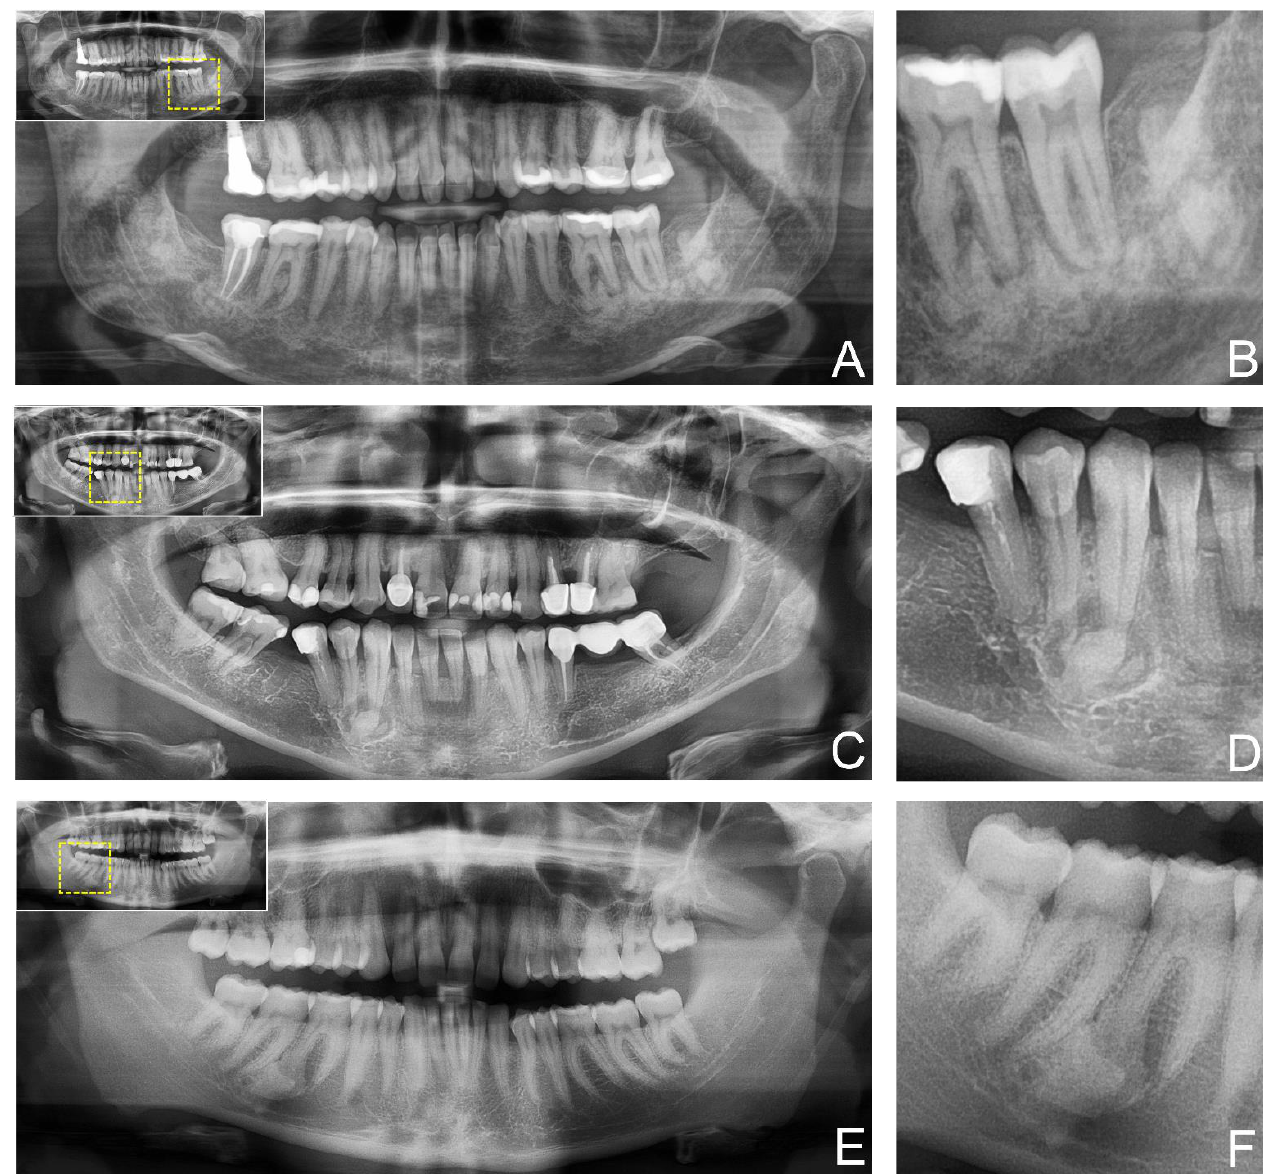
Figure 2. Study participants’ two-dimensional panoramic radiography (PAN) providing anatomical information of the fibro-osseous lesion. ( A ) shows an ossifying fibroma in the posterior mandible. In contrast ( C ) shows cemento-osseous dysplasia at the canine in the fourth quadrant, while ( E ) shows a cemento-osseous dysplasia at the first molar in the fourth quadrant. For orientation, the dotted rectangles in the corner show the enlarged area of the region of interest ( B,D,F ). Bone biopsies for histopathological diagnosis were taken in 100% of patients with ossifying fibroma and fibrous dysplasia; slightly less patients with cemento-osseous dys- plasia underwent a biopsy (90%). Surgical resection of the lesion was mostly performed in patients with ossifying fibroma (41%), followed by fibrous dysplasia (29%) and ce- mento-osseous dysplasia (15%). The main complaints before the surgical intervention were pain, swelling, or sensory disturbance; otherwise, the occurrence of a relapse was an indication. A recurrence of cemento-osseous dysplasia in 5% and ossifying fibroma in 6% was observed after initial resection. The postoperative follow-up interval for cemento-os- seous dysplasia was set at 6 months in 45% of cases, while for the rest, the follow-up in- terval was largely determined according to the patient’s needs. For ossifying fibromas, the interval was set at 6 months in 76% of cases, whereas for fibrous dysplasia, the follow-up